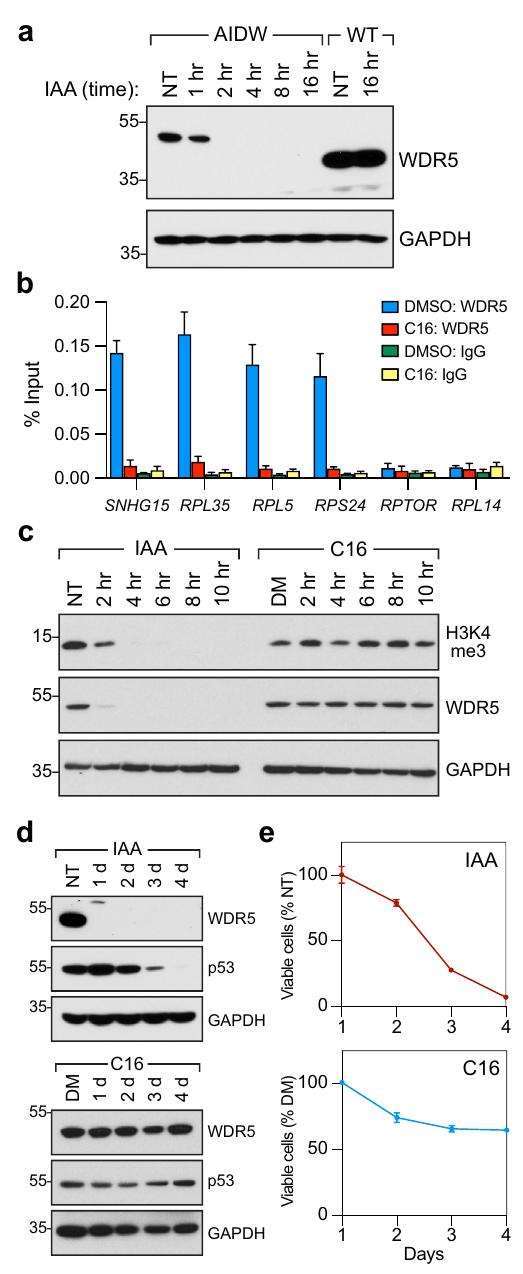
Figure 1. A system to compare loss of WDR5 with WIN site inhibition. ( a ) Wild-type (WT) Ramos cells, or AIDW Ramos cells, were not treated (NT) or treated for the indicated times with 100 μM IAA. WDR5 and GAPDH levels were determined by Western blotting. N = 3. ( b ) AIDW cells were treated with DMSO or 500 nM C16 for 18 h, and ChIP performed with an α-WDR5 antibody or IgG control. Co-precipitating DNAs corresponding to the indicated loci were detected by qPCR. RPTOR and RPL14 are not bound by WDR5. Error bars are standard error. N = 3. ( c ) AIDW cells were treated with 100 μM IAA or 500 nM C16 for the indicated times and H3K4me3, WDR5, and GAPDH levels determined by Western blotting. “NT”; not treated. “DM”; DMSO control. N = 3. ( d ) As in ( c ) but treatments were for four days, and blots probed for WDR5, p53, and GAPDH. N = 3. ( e ) AIDW were treated with 100 μM IAA (top) or 500 nM C16 (bottom) for 1 to 4 days, viable cell numbers determined, and expressed as a percentage of the not treated (NT) or DMSO-treated (DM) control cultures. Error bars are standard error. N = 3. For ( a,c,d ) unprocessed blots are presented in Supplementary Fig.